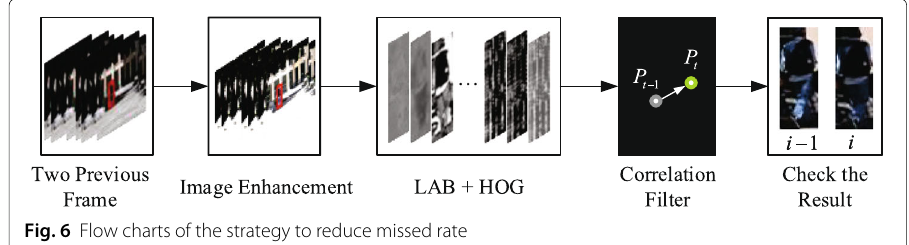
Fig. 6 Flow charts of the strategy to reduce missed rate